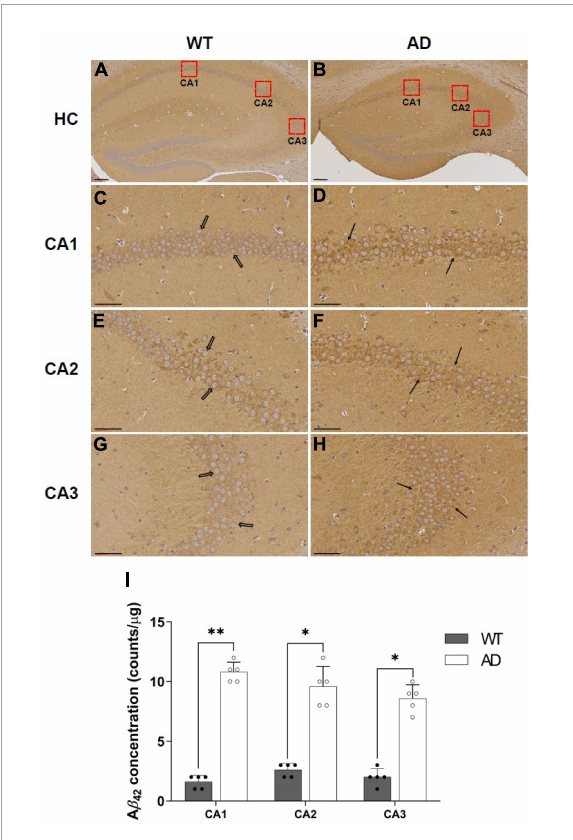
FIGURE6 Immunohistochemical staining of A β 42 peptide in the hippocampus for wild-type (WT) and Alzheimer’s disease (AD) mice (A–H) . (A,B) 100 × magnification of the hippocampus, (C–H) 400 × magnification of the hippocampal regions such as CA1, CA2, and CA3 (Scale bar = 60 µ m). The number of A β 42 peptides in the CA1, CA2, and CA3 regions are expressed as mean ± SD ( I , ∗ p < 0.05, and ∗∗ p < 0.005). This analysis was done for all mice ( n =